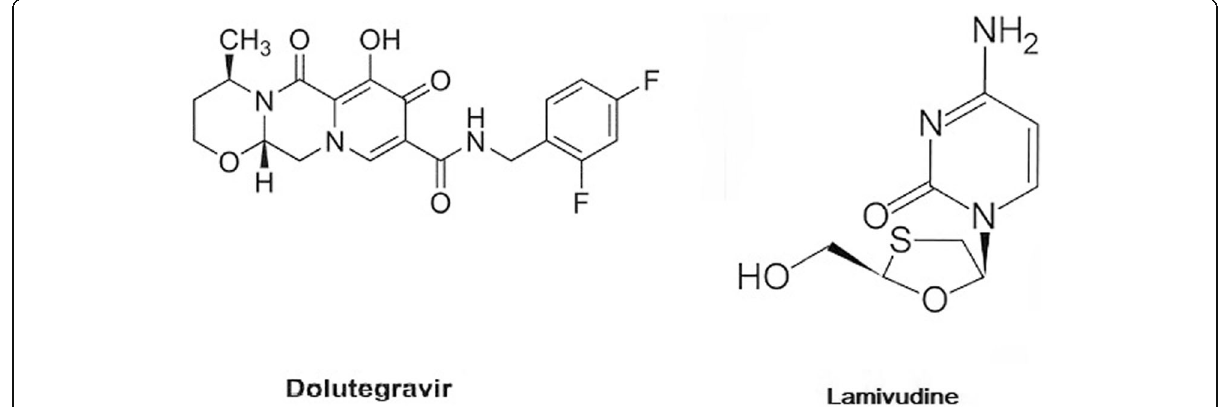
Fig. 1 Chemical structures of Dolutegravir and